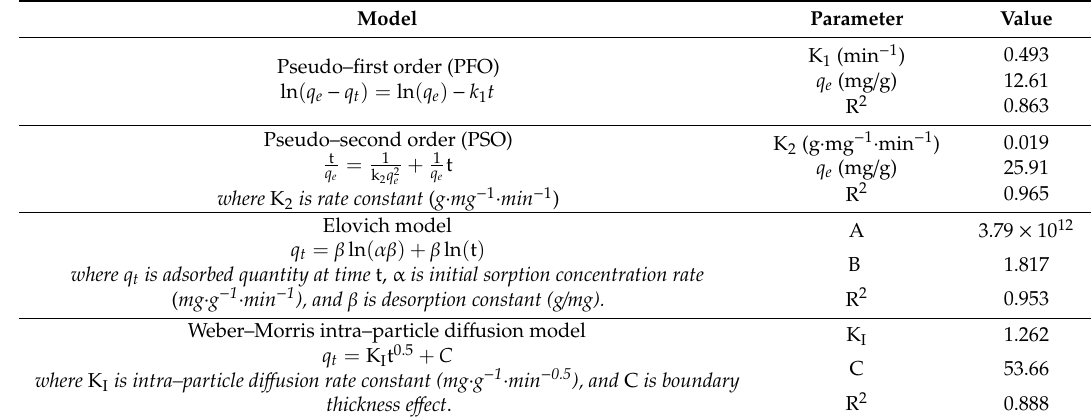
Table 8. The kinetics study results corresponding to Figure